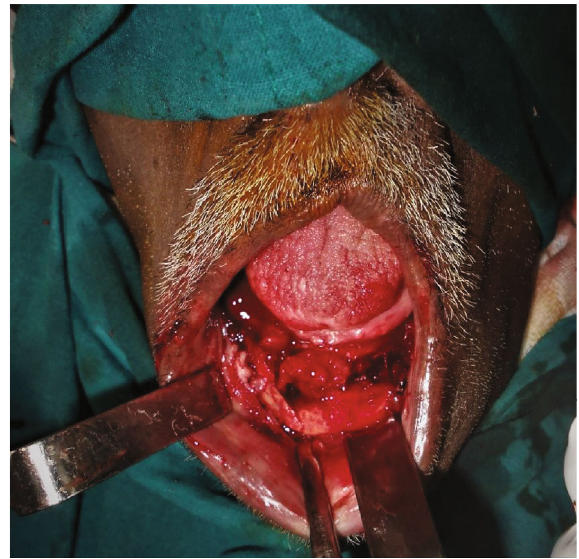
Figure 5: Coronal CT image.